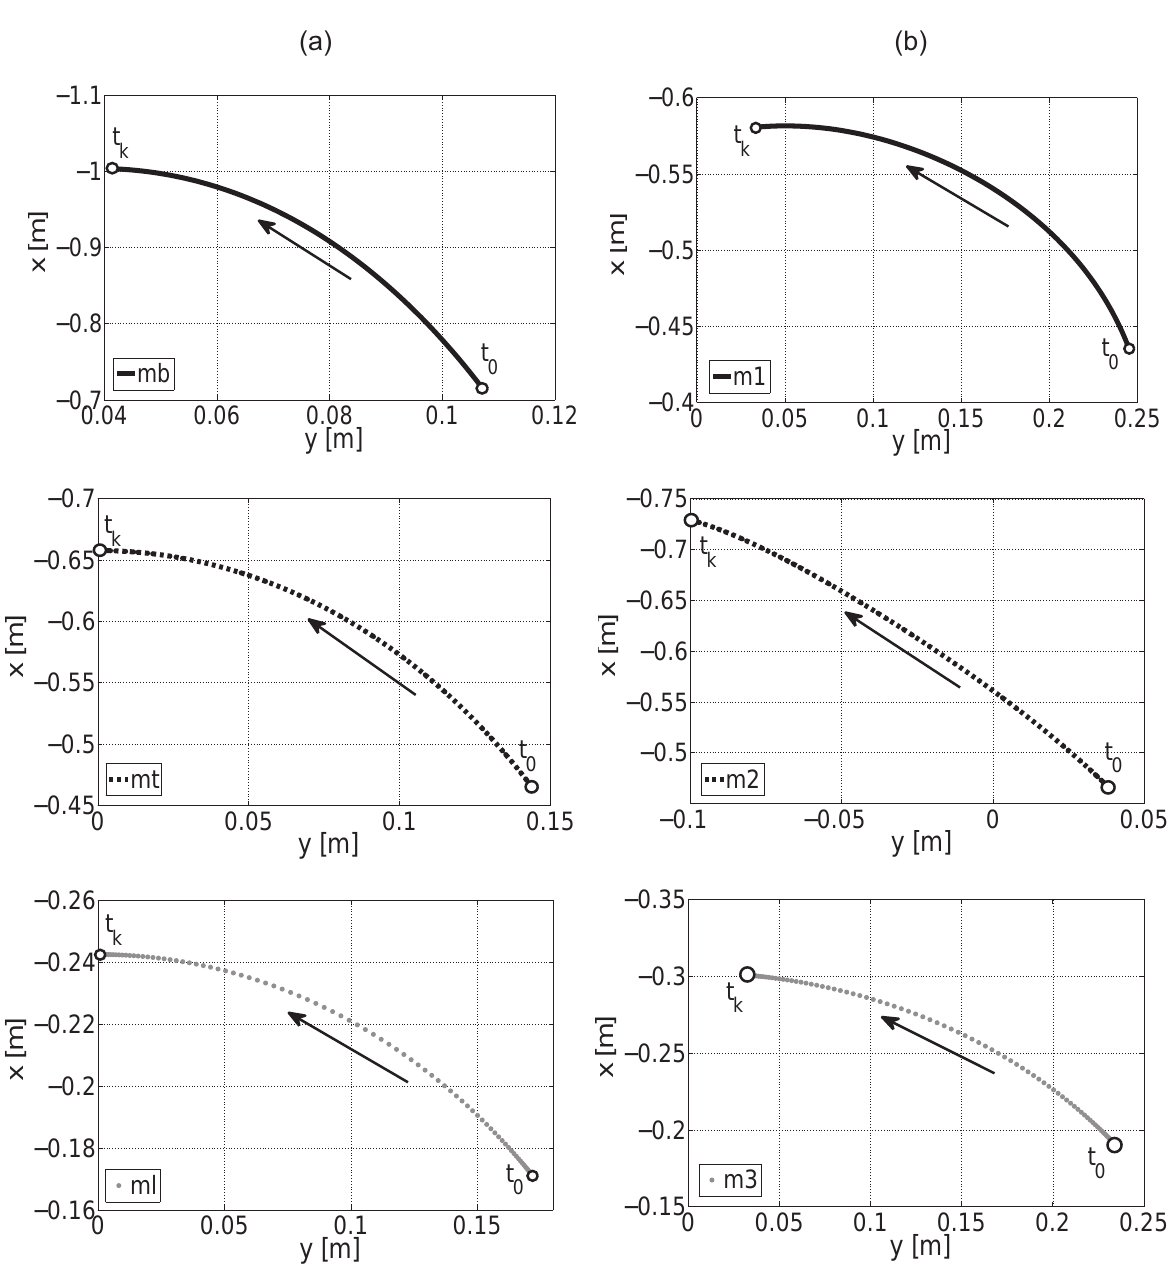
Figure 2. Movement trajectory of the mass center of the trunk, thigh, and shank ( a ), movement trajectory of the mass center of actuators 1, 2, 3 ( b ). The velocity values on x- and y-axis for individual point masses are presented in Figure 3. The highest values of velocity (about 1 m/s) were obtained by the actuator for the knee joint on the y-axis. The lowest values of velocity on the x- and y-axis were observed for the mass center of the